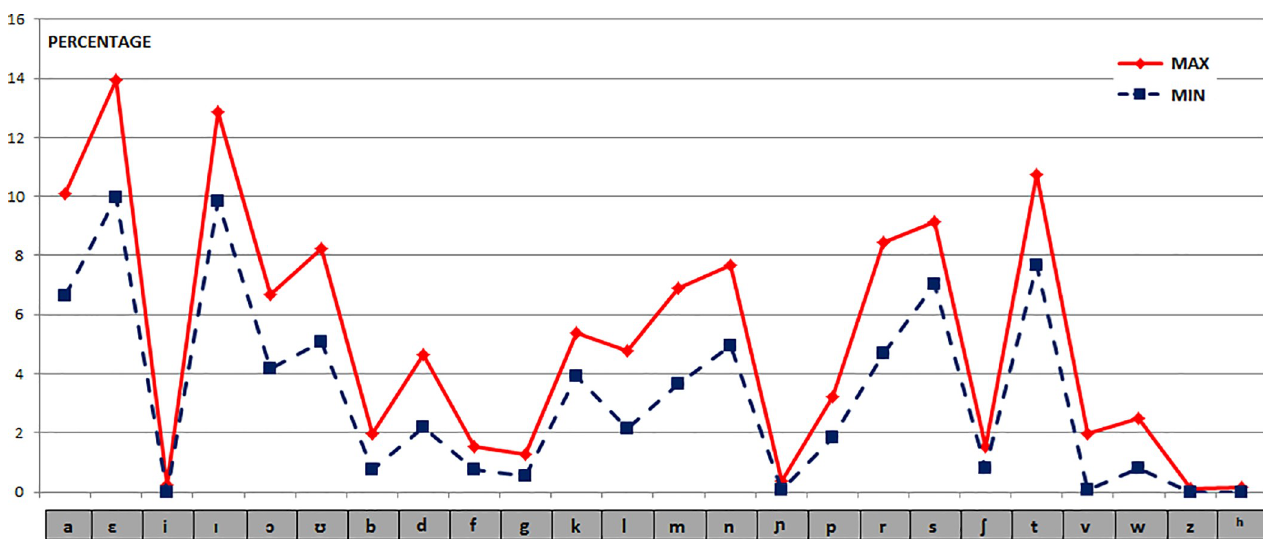
Fig 5. Frequency values of the phonetic units of the 10 Latin texts.